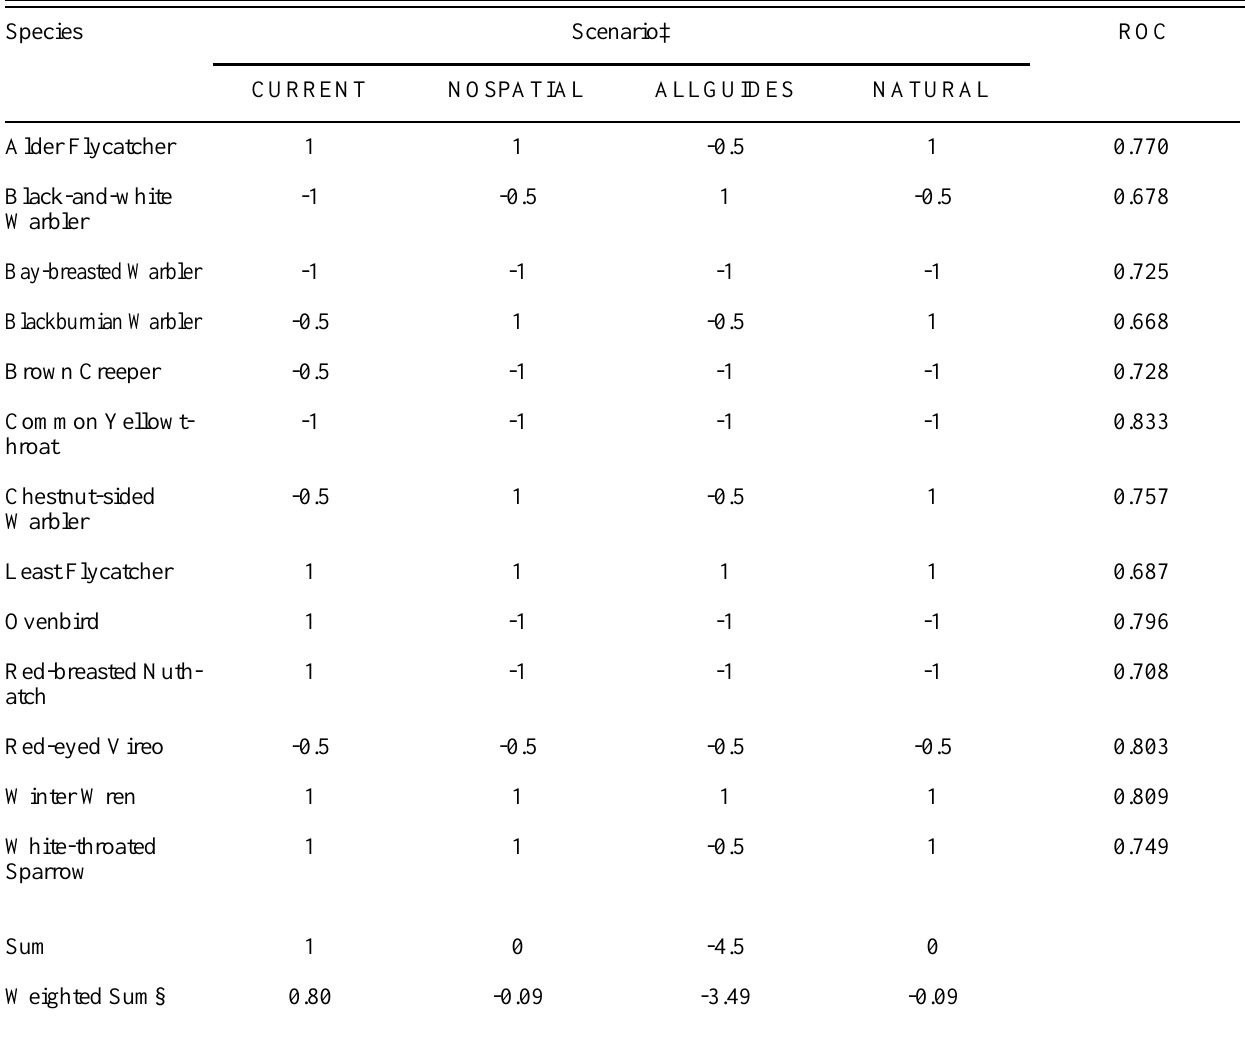
Table 5. Summary of habitat response† relative to simulated range of natural variation (SRNV) for modeled variables at year 0 (CURRENT) and at year 100 (NOSPATIAL, ALLGUIDES, and NATURAL).